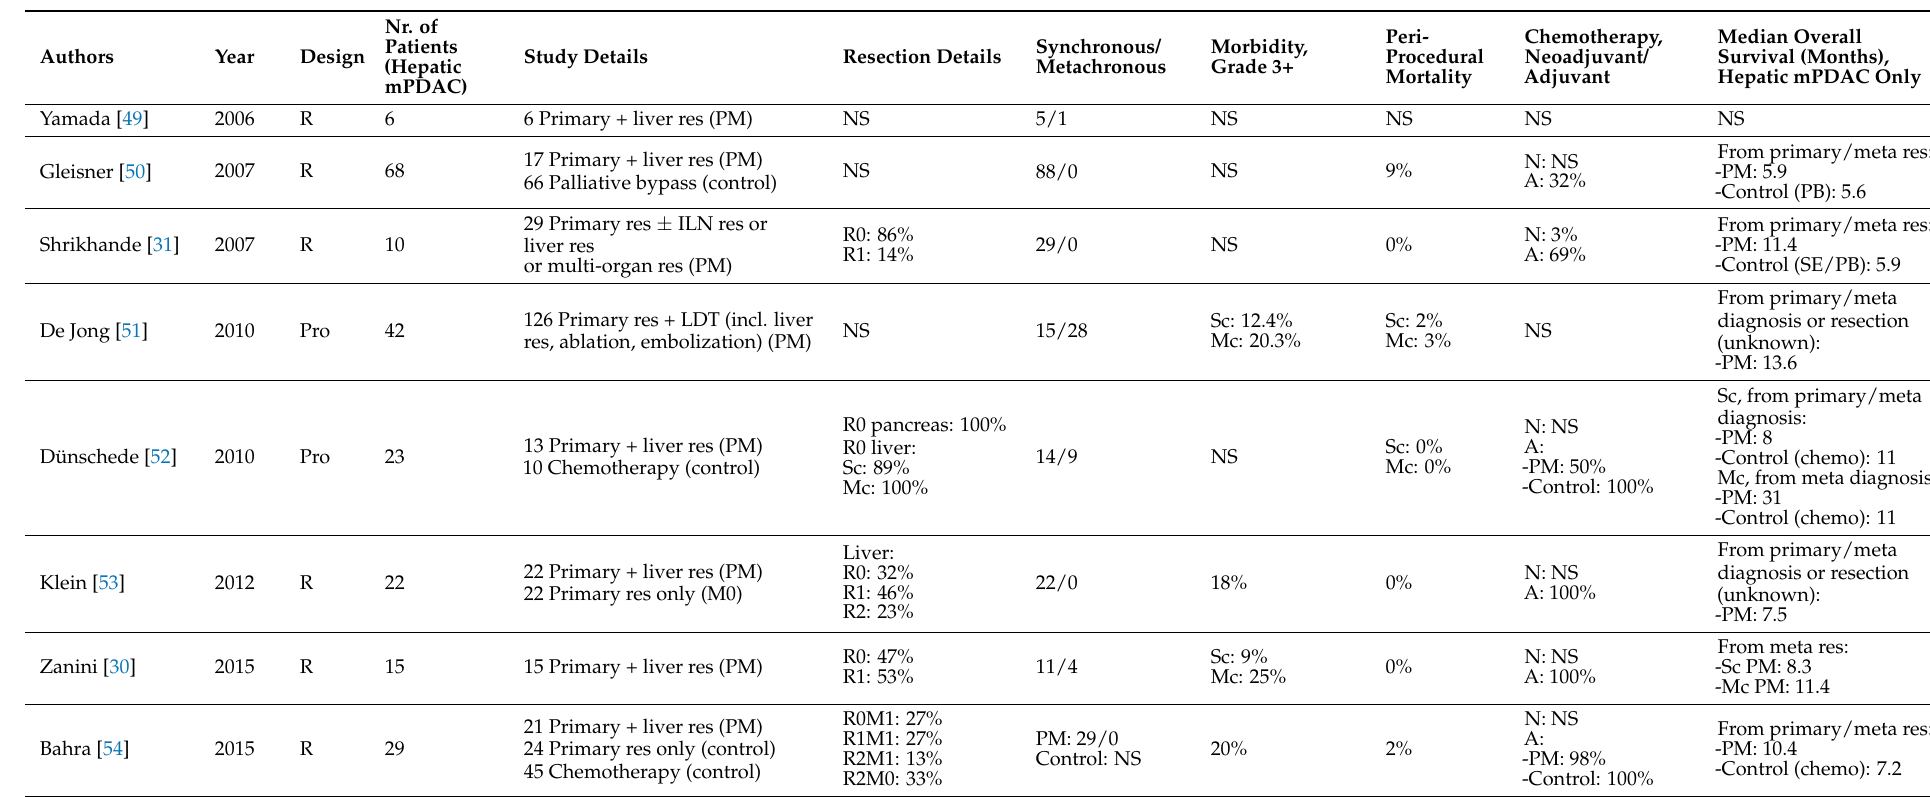
Table 3. Hepatic metastasectomy in mPDAC. NS = not specified; R = retrospective; Pro = prospective; PM = primary + metastatic resection; P = primary resection; M = metastatic resection; res = resection; chemo = chemotherapy; SE = surgical exploration; PB = palliative bypass; ILN = inter-aortocaval lymph node; LDT = liver-directed therapy; meta =